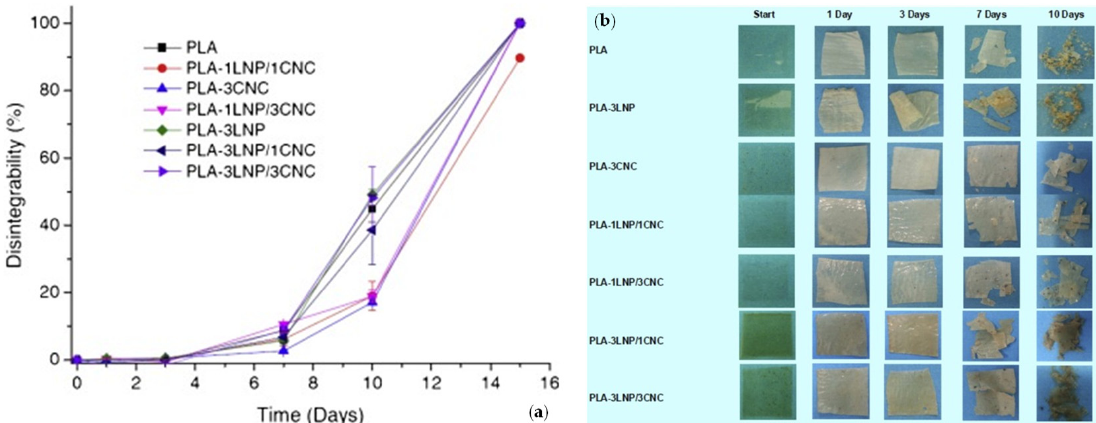
Figure 6. Disintegrability values ( a ) and visual images ( b ) of PLA and PLA binary and ternary nanocomposites at different incubation times in composting conditions. Reprinted with permission from Ref. [46]. Copyright 2016, Elsevier Ltd.